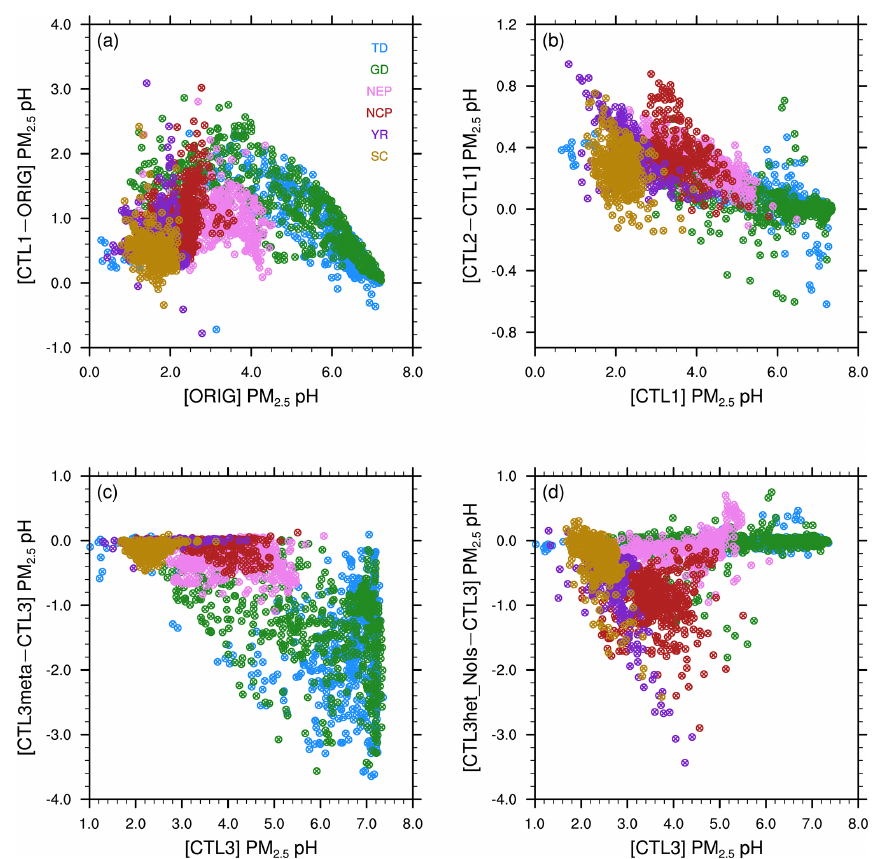
Figure 5. Scatterplots of the surface PM 2 . 5 pH differences between (a) CTL1 and ORIG scenarios, (b) CTL2 and CTL1 scenarios, (c) CTL3meta and CTL3 scenarios, (d) CTL3het_NoIs and CTL3 scenarios vs. the corresponding original pH, separated by regions. Different scales are